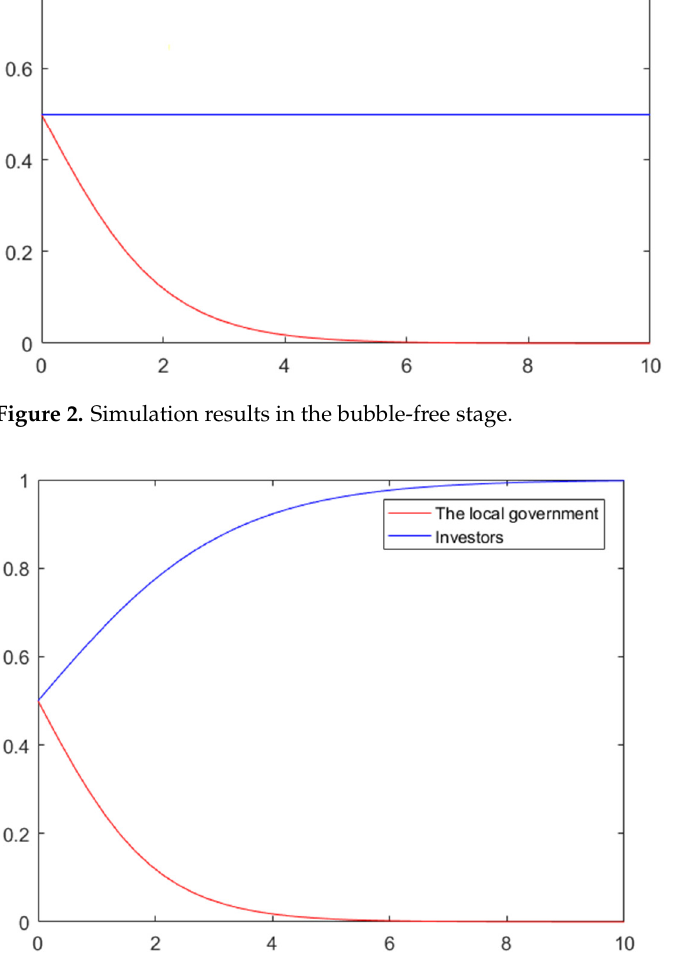
Figure 5. Simulation results in the bubble expansion stage .